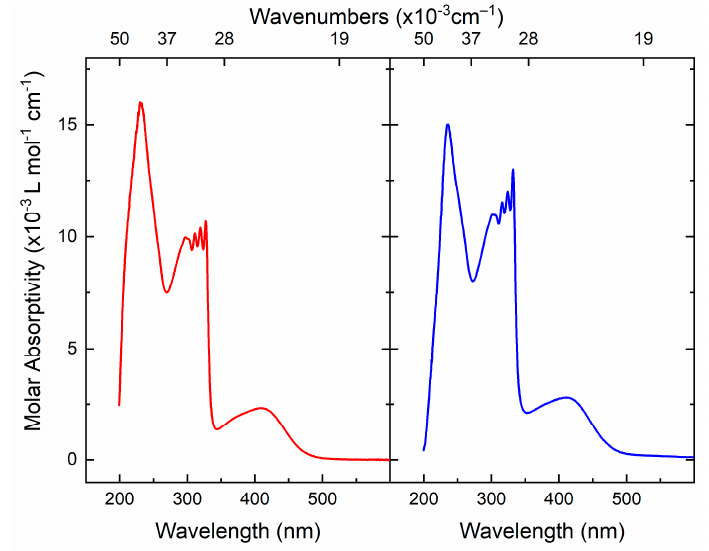
Figure 2. Electronic absorption spectra for 2 (left panel) and 3 (right panel) in MeCN.